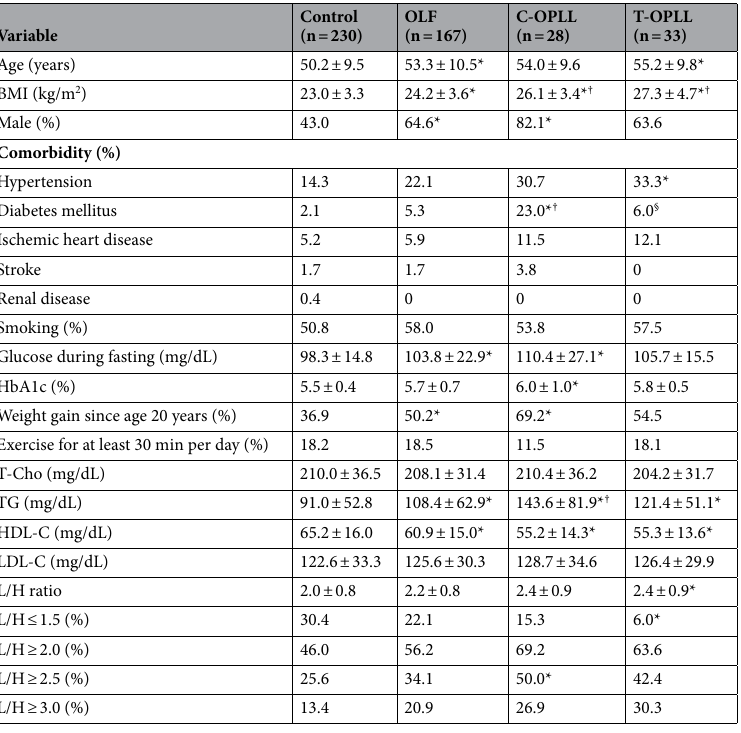
Table 2. Comparison of clinical characteristics between subjects without ligamentous ossification (control group) and those with OLF, C-OPLL, and T-OPLL. Data are shown as mean ± SD or as percentage. L/H ratio represents LDL-C/HDL-C. (* P < 0.01 vs. control group). ( † P < 0.01 vs. OLF group). ( § P < 0.01 vs. C-OPLL group). OPLL, ossification of the posterior longitudinal ligament; OLF, ossification of the ligamentum flavum; BMI, body mass index; T-Cho, total cholesterol; TG, triglycerides; HDL-C, high-density lipoprotein cholesterol; LDL-C, low-density lipoprotein cholesterol; C, cervical; T, thoracic.